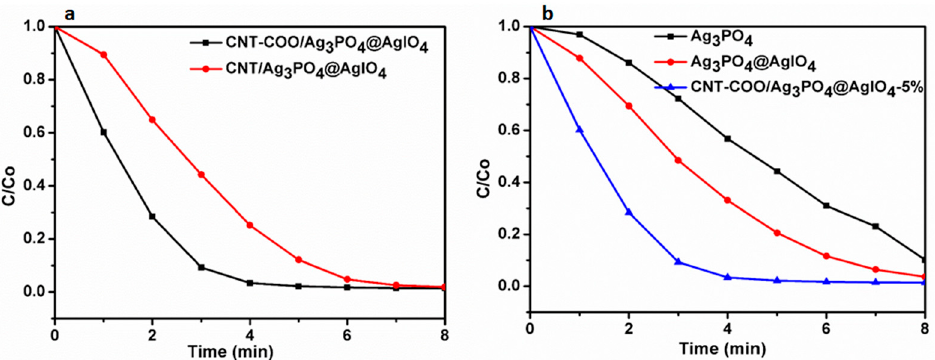
Figure 6. The photodegradation degradation of MB over ( a ) CNT-COO − /Ag 3 PO 4 @AgIO 4 and CNT/Ag 3 PO 4 @AgIO 4 ( b ) Ag 3 PO 4 , Ag 3 PO 4 @AgIO 4, and CNT-COO − /Ag 3 PO 4 @AgIO 4 , under sunlight irradiation.